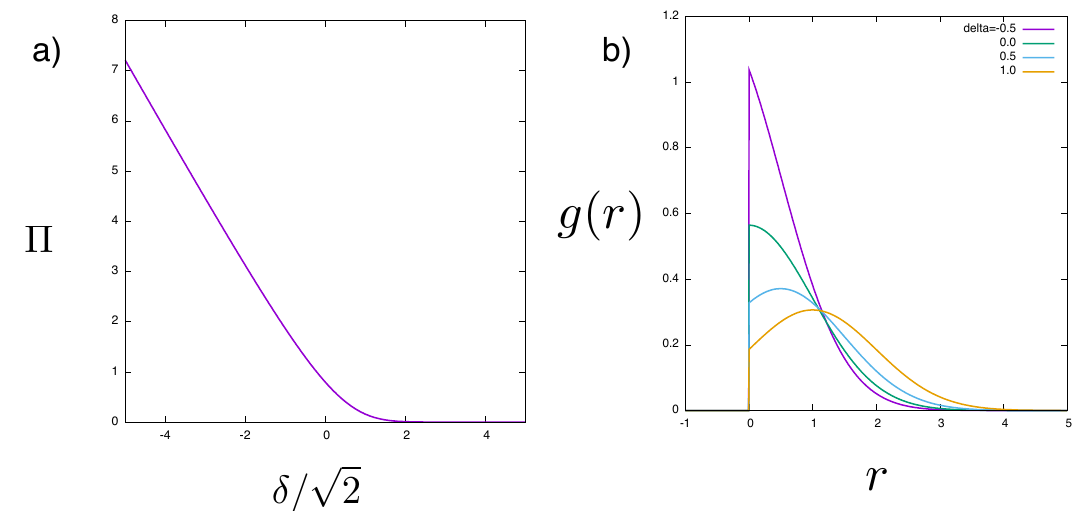
Figure 5: Liquid phase (RS solution with q = 0) of the hardcore model: a) behav- ior of the pressure Π and b) the distribution of the gap g ( r ) . Note that these are independent of p